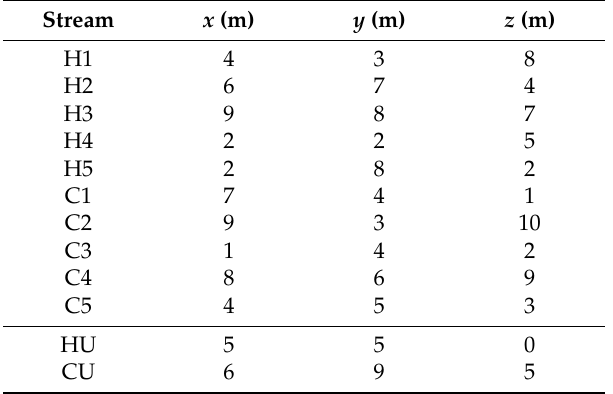
Table 3. Additional Cartesian coordinates for the 10SP1